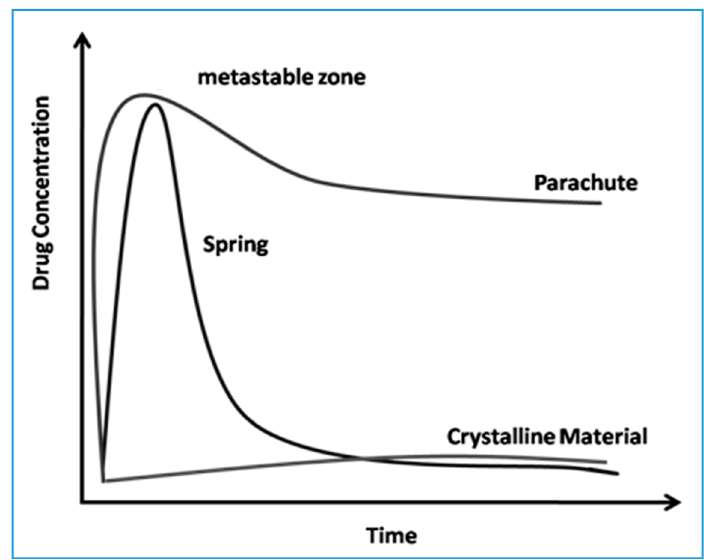
Figure 2. The ‘spring and parachute’ approach to promoting and maintaining supersaturation of poorly soluble drugs. Adapted with permission from Cryst. Growth Des., 2011, 11 (7), 2662–2679. Copyright 2011 American Chemical Society.